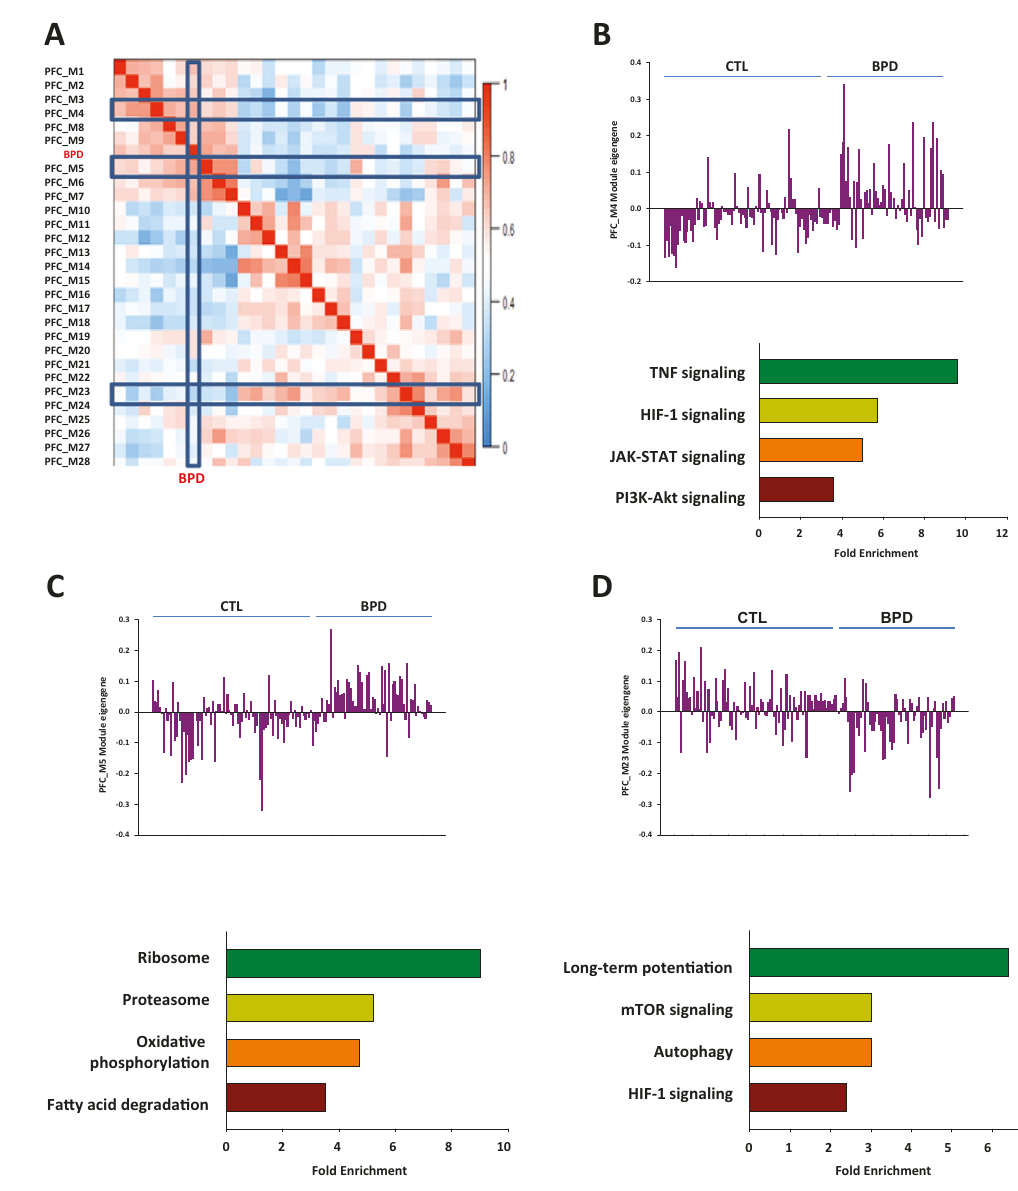
Fig. 1 Co-expression modules differentially expressed between BPD and controls in PFC. The eigengene adjacency heatmap of the modules ( A ), the eigengene values across samples and major KEGG pathways signi fi cantly enriched in the genes in the PFC_M4 module ( B ), the PFC_M5 module ( C ) and the PFC_M23 module ( D